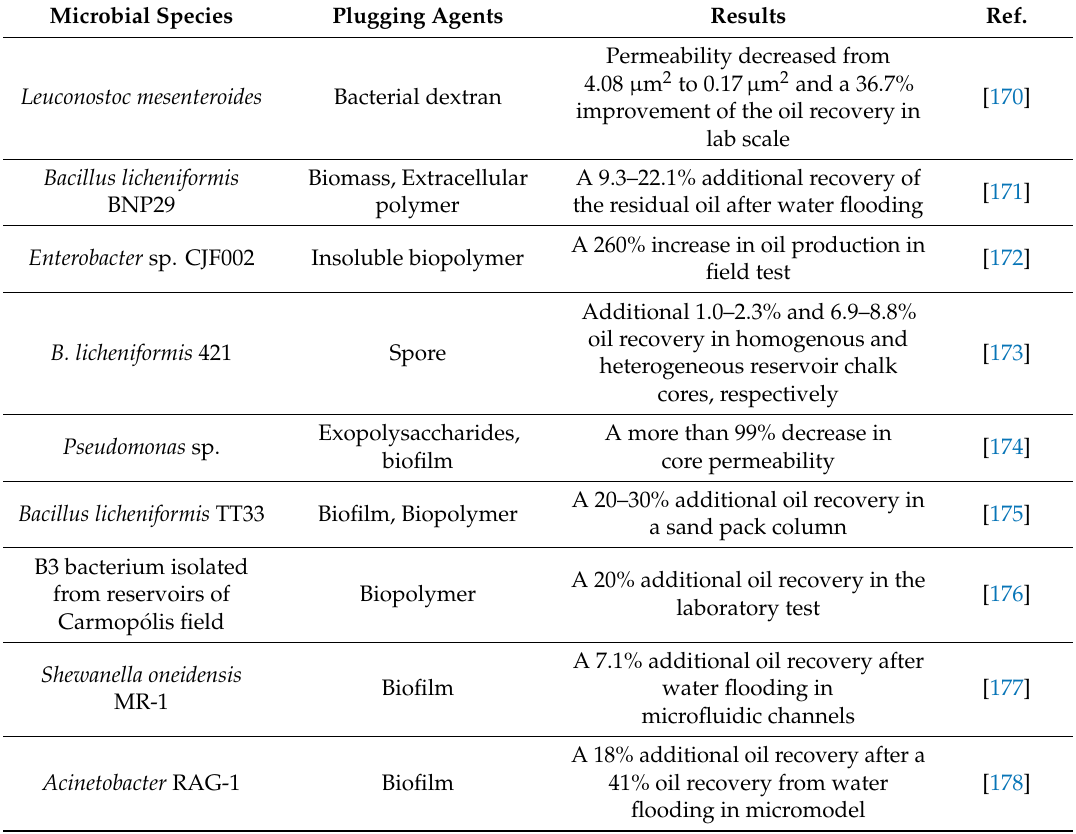
Table 8. Examples of permeability manipulation with microbial